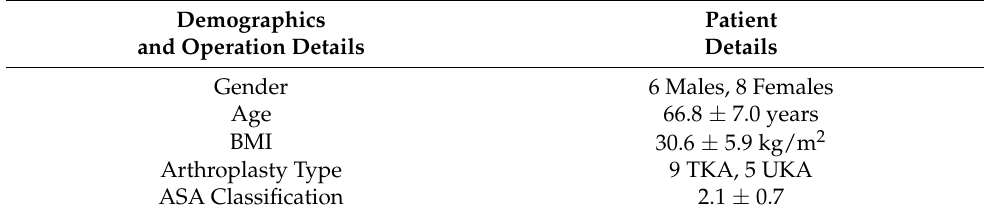
Table 1. Patient Demographics and Operation Details. Data presented as mean ±